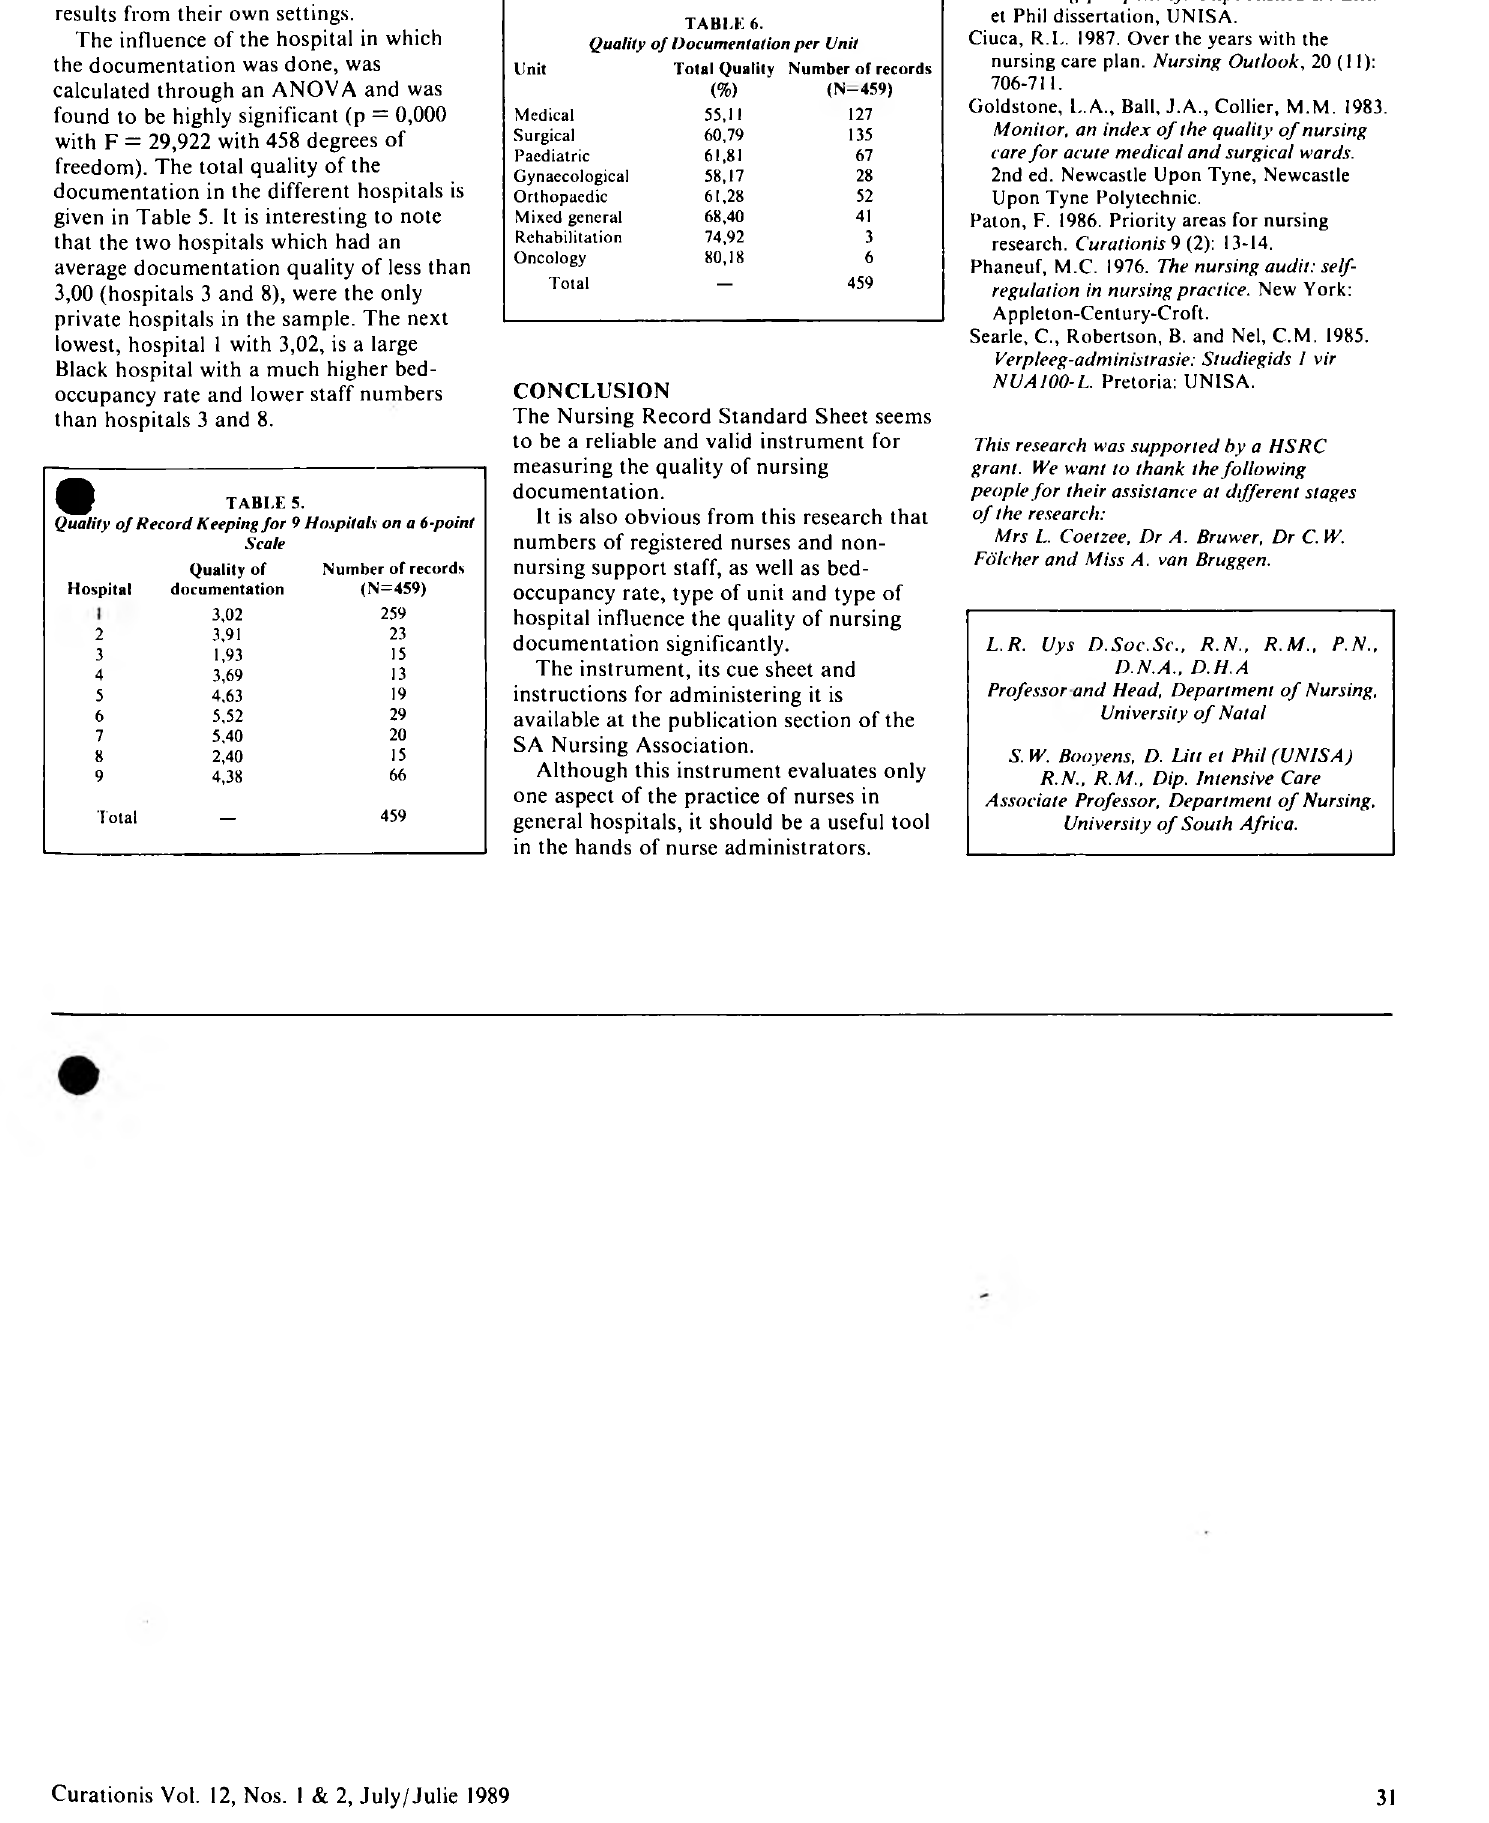
TABLE 6. Quality of Documentation per Unit